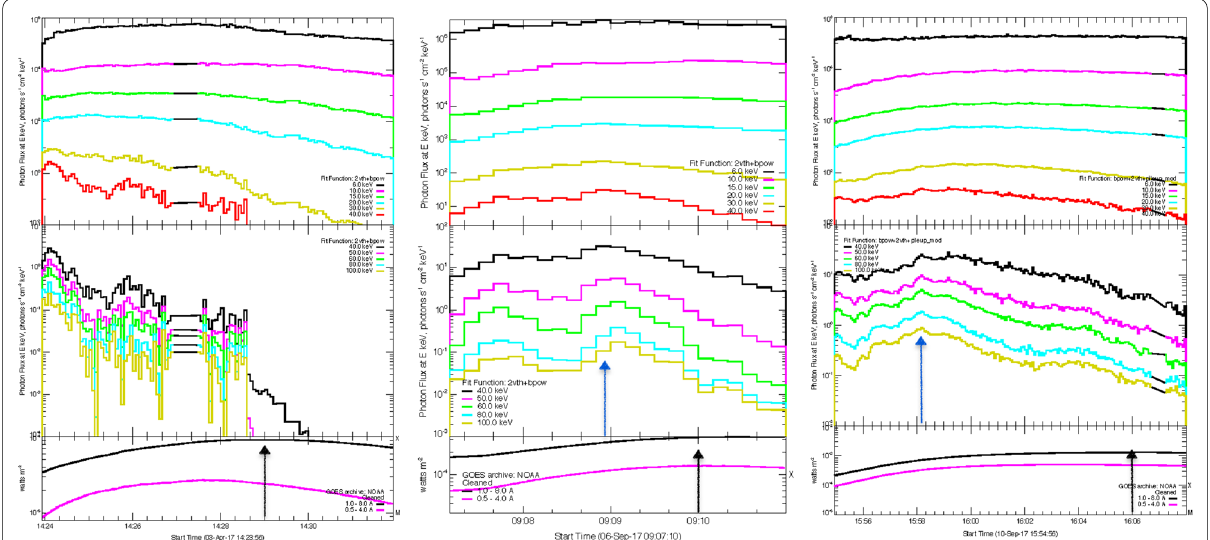
Fig. 6 Time profiles for three flares, M5.8 (April 3, 2017), X2.2 (September 6, 2017) and X8.2 (September 10, 2017) from left to right. For each event, the top and middle panels display RHESSI profiles (respectively, in the energy band 6 to 40 kev and 40 to 100 keV) and the bottom panel displays the two energy bands of GOES. The black arrows indicate the peak time of SXR and the blue arrows the peak time of the 40 keV